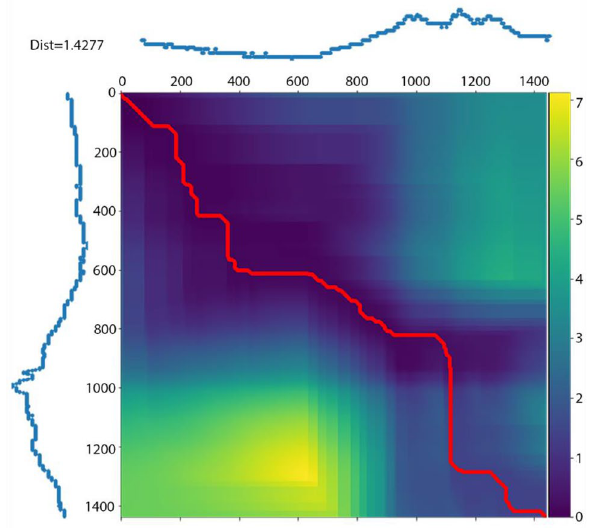
Figure 1. Dynamic Time Warping (DTW) alignment of two 24-h time series of outdoor temperature (at minute-level resolution so 60 × 24 = 1440 min long) from two measurement sites, with the color gradient displaying all pairwise Euclidean distances between time points (blue indicates the shortest distances) and the red line shows the shortest